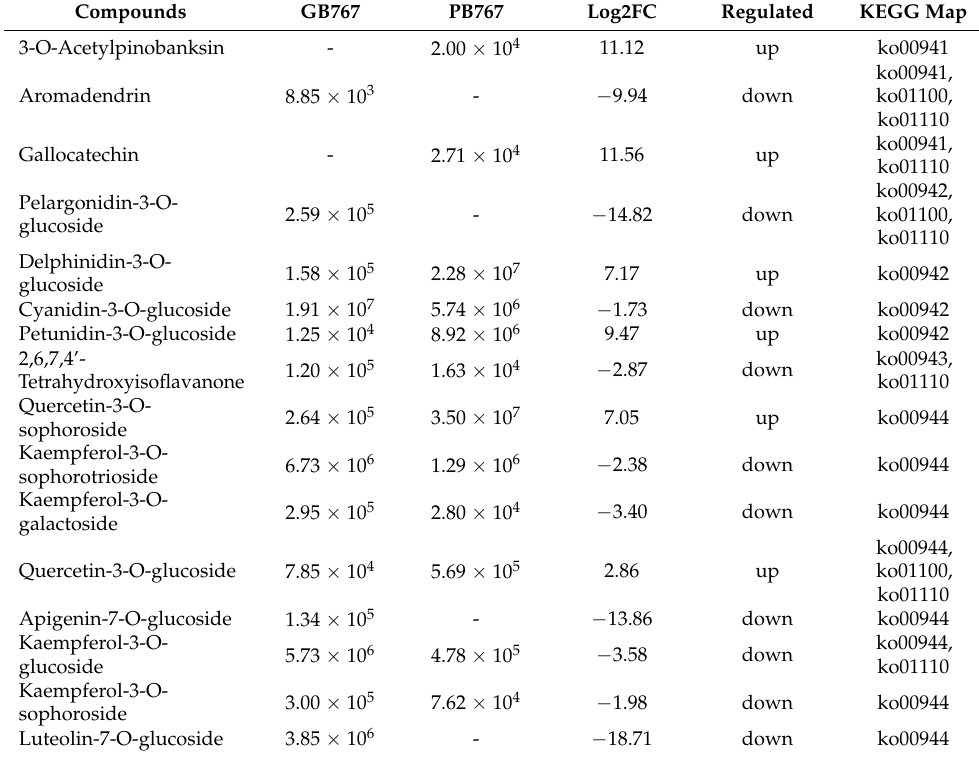
Table 2. Differentially produced intermediate metabolites in anthocyanin-related pathways between GB767 and